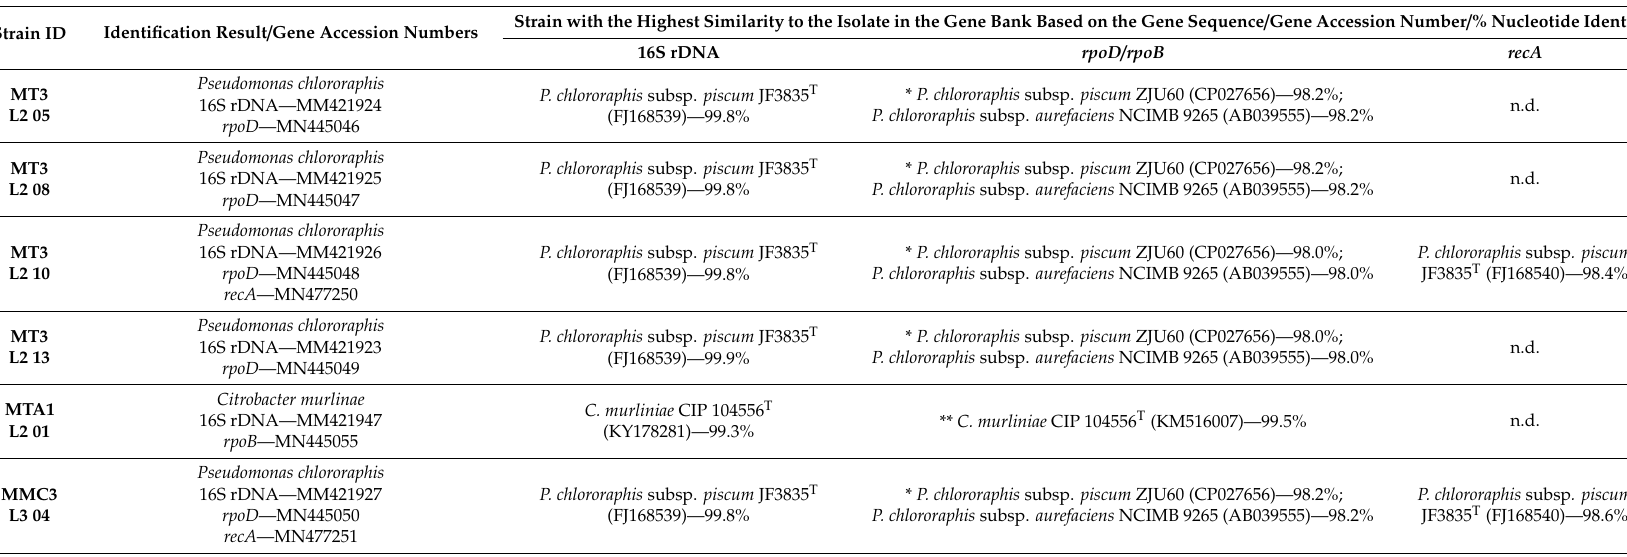
Table 4. Molecular identification of bacterial strains with antimicrobial activity against EPB isolated from the midgut of M. melolontha larvae. Strain